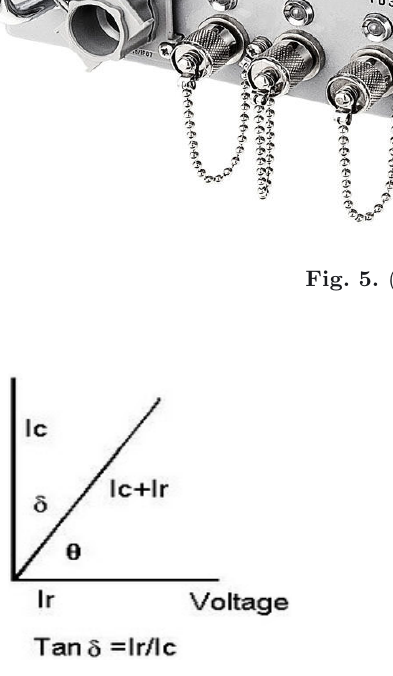
Fig. 6. Principle of